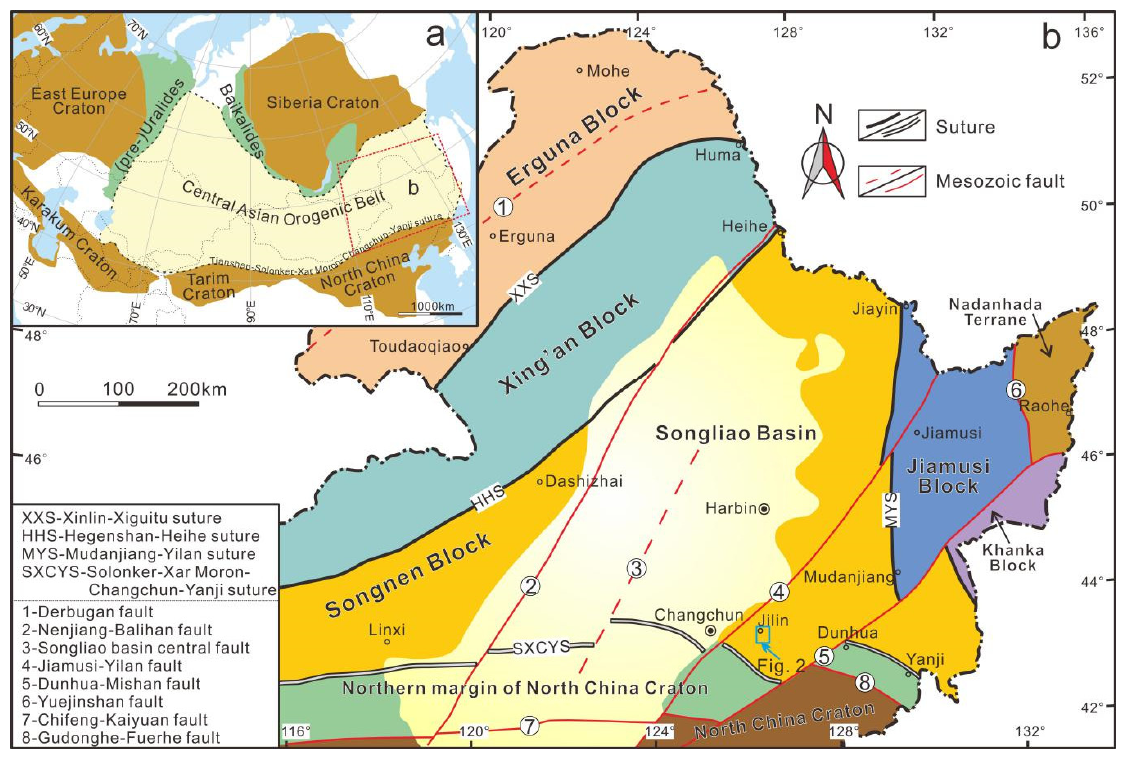
Figure 1. ( a ) Tectonic outline of the Central Asian Orogenic Belt (CAOB) and surrounding regions (modified from [74]); ( b ) Tectonic sketch map of NE China (modified from [5]).